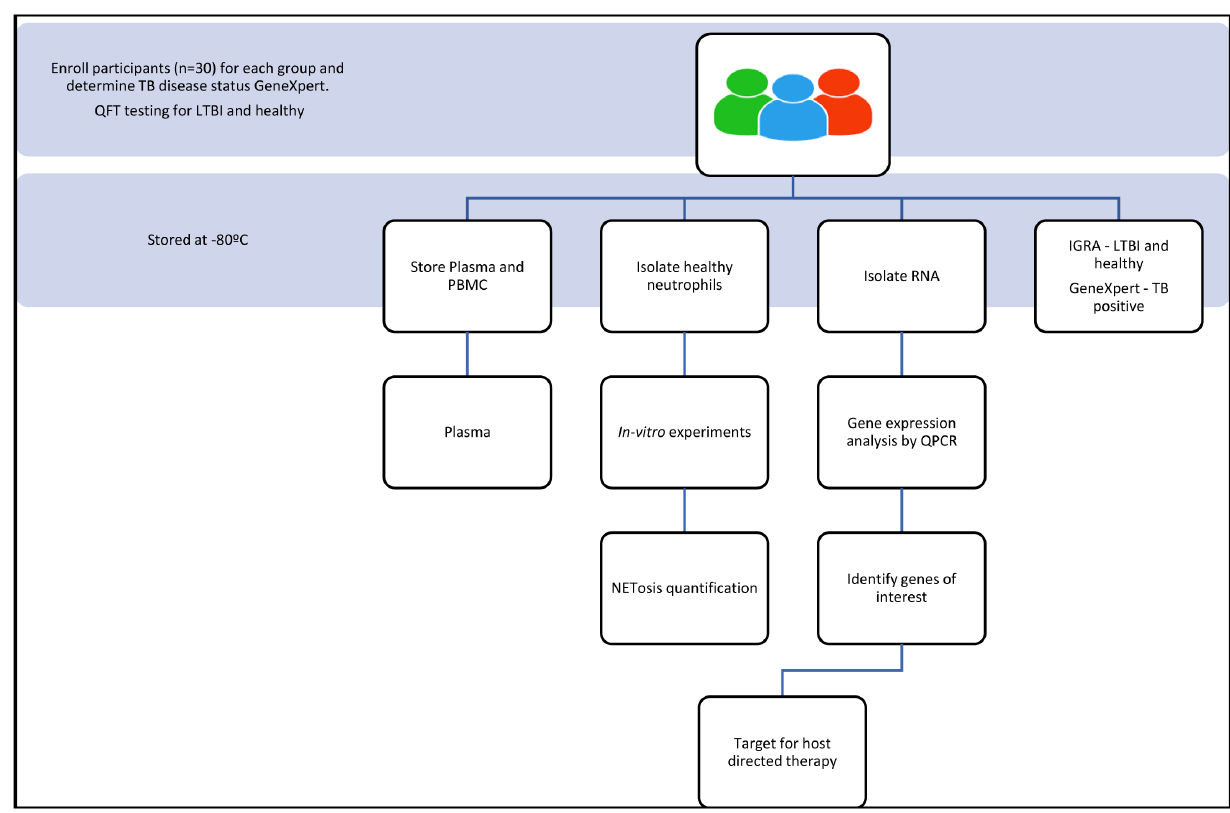
Figure 1. Schematic of the study design and experimental process that will be followed.